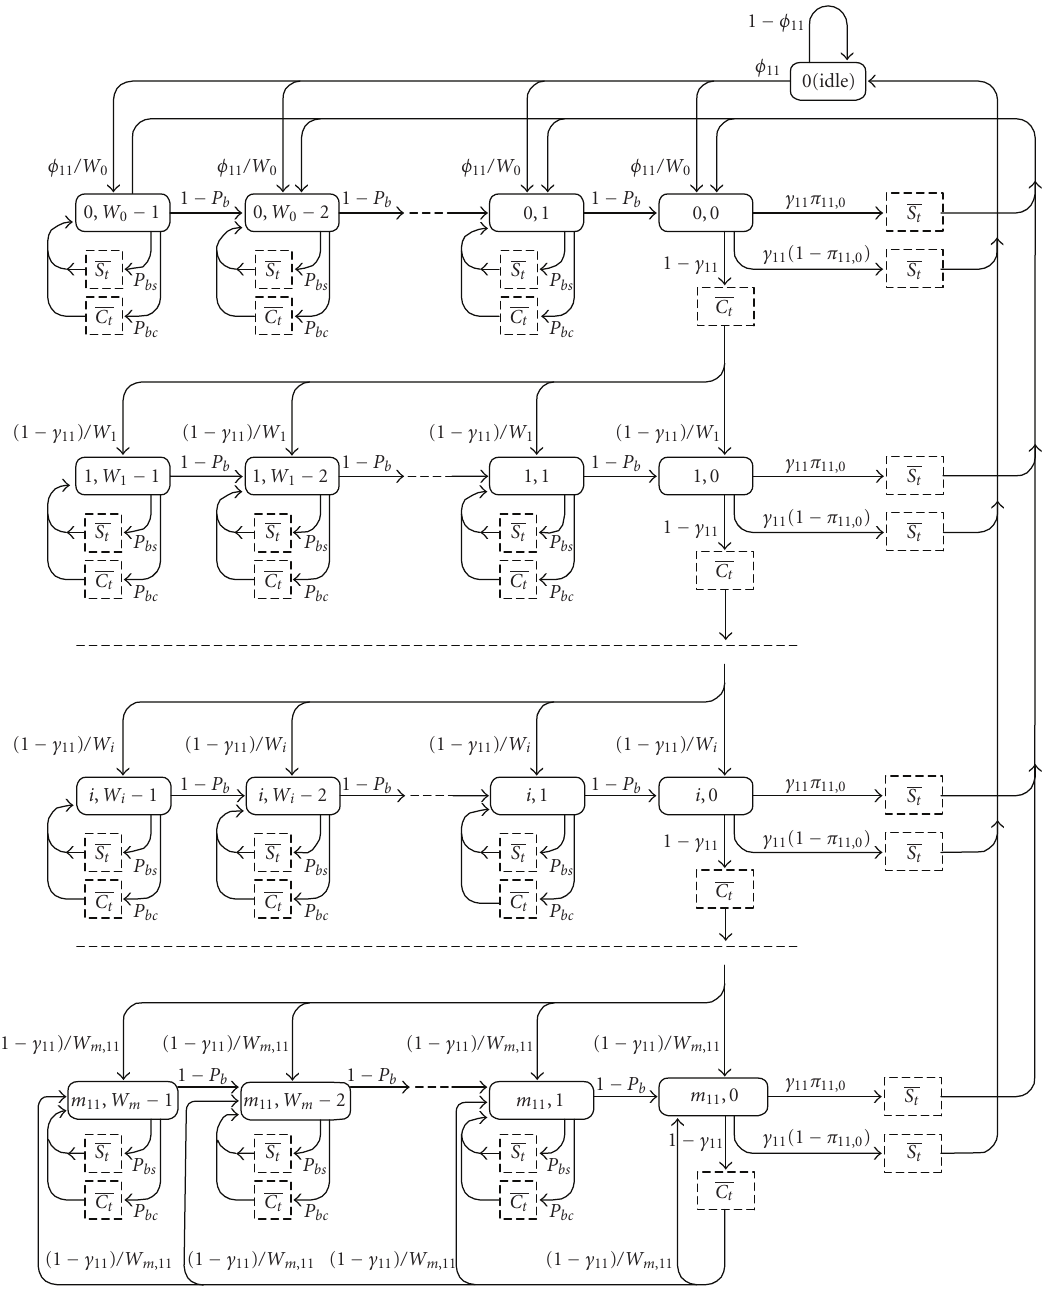
Figure 4: Markov chain for IEEE 802.11b coupled with device’s